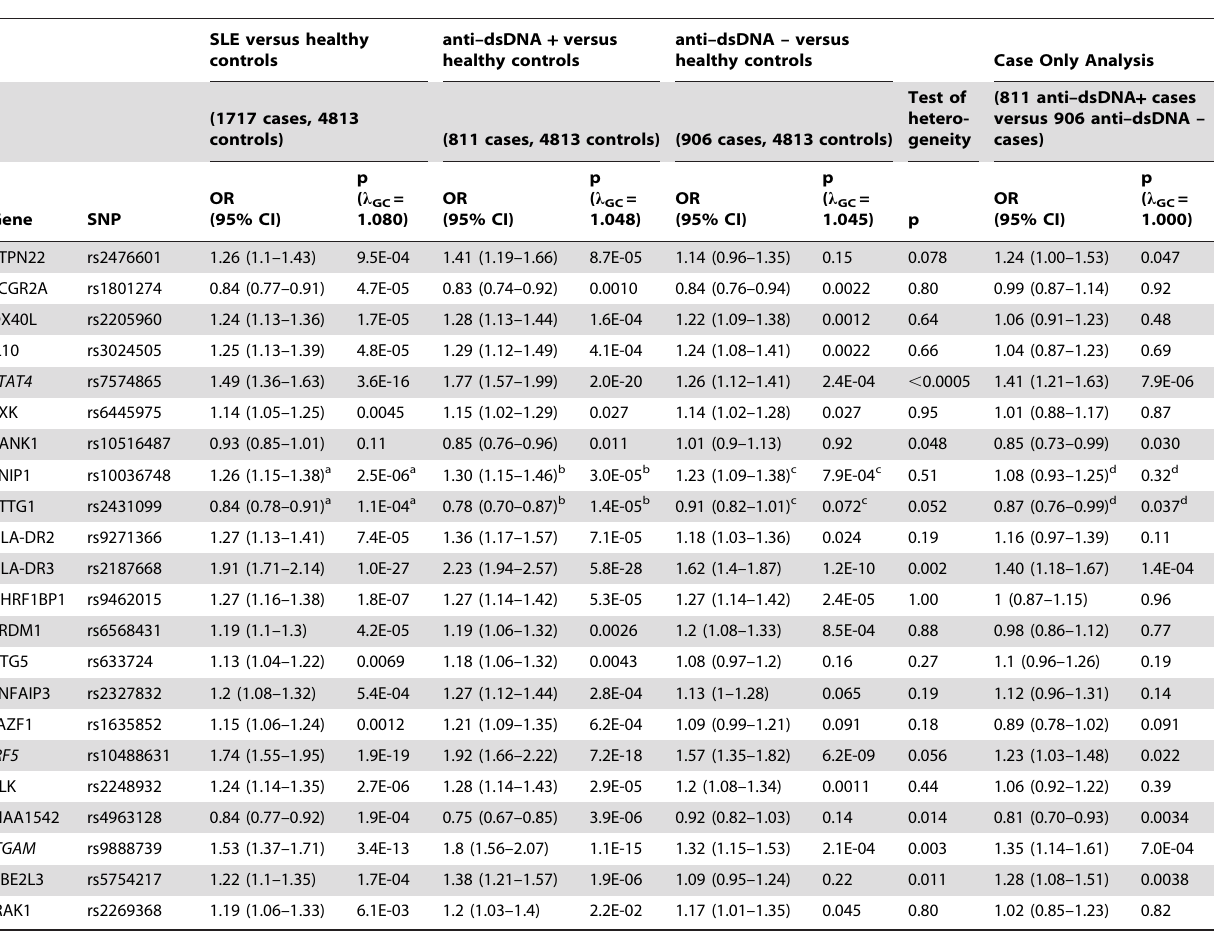
Table 5. Comparison of association results for loci associated with systemic lupus erythematosus described in Gateva et. al [7], stratified by anti–dsDNA autoantibody